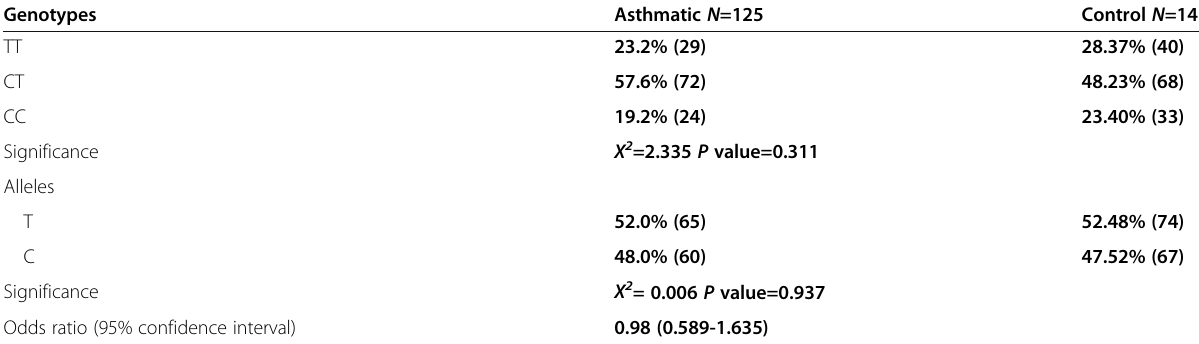
Table 4 The distribution of rs1420101 ( IL1RL1 gene) polymorphism genotype and allele frequencies in the Algerian population studied